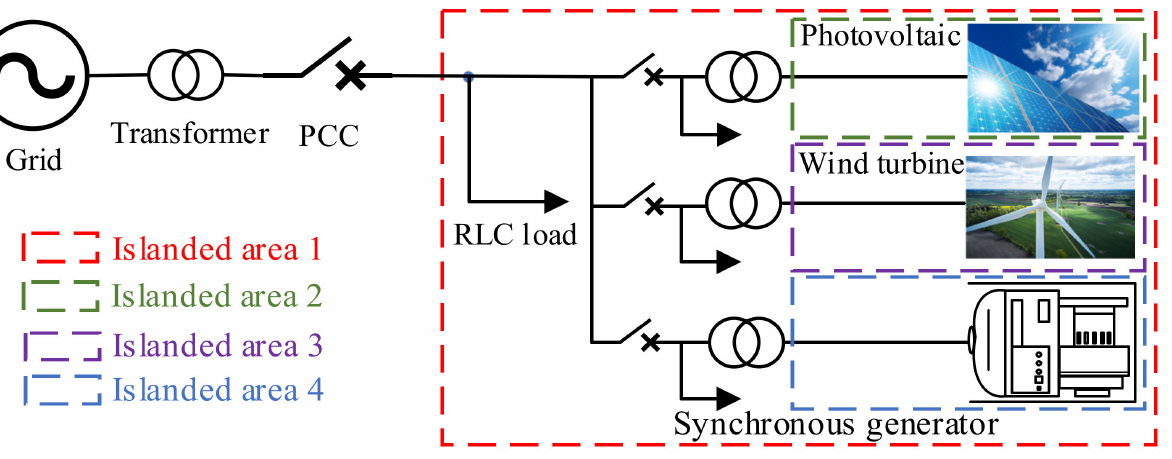
Figure 1. Formation of